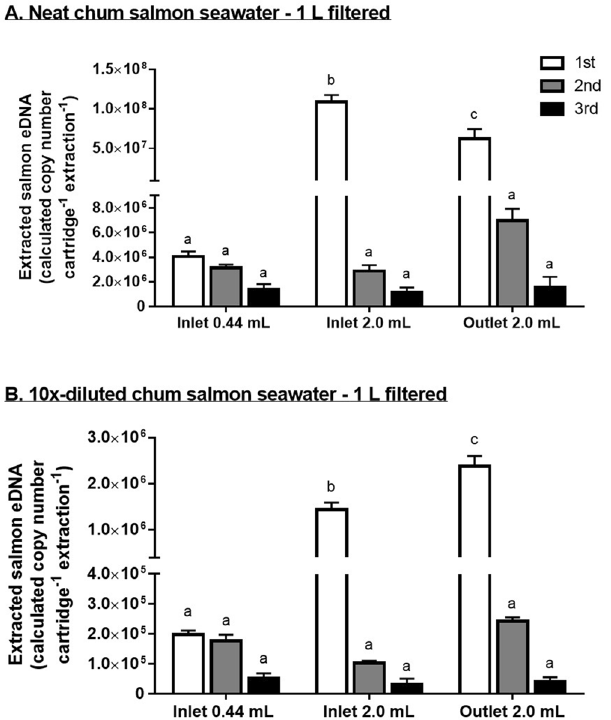
Figure 1. Workflow and various protocols examined. Two concentrations of chum salmon tank water (neat vs. 10×-diluted) were filtered to simulate low and high sample inputs. Three protocols are presented schematically to indicate the modifications (refer to main text for details). A spin column fitted to a 50 mL centrifuge tube is used to collect the lysate from the Sterivex cartridge. Ethanol is added to the lysate and the mixture is loaded on the DNeasy